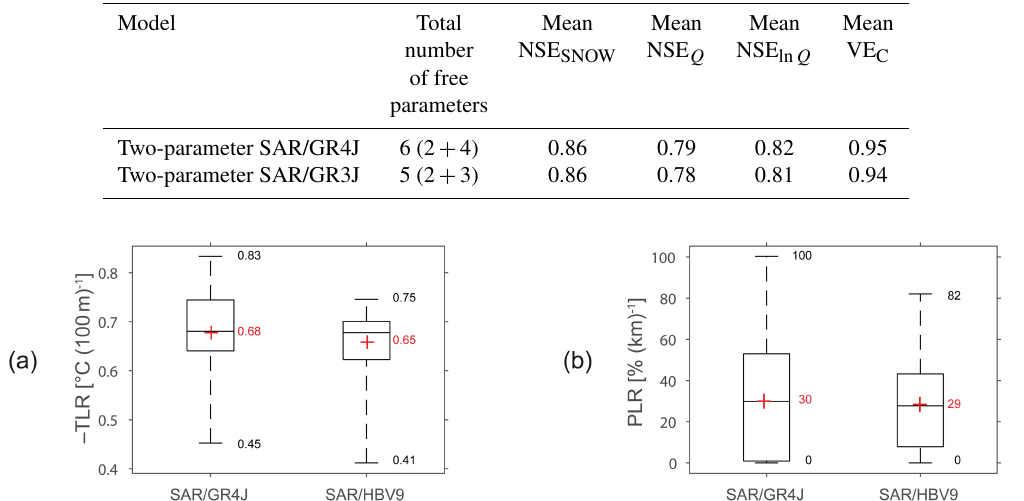
Figure 9. Boxplots (showing 0.00, 0.25, 0.50, 0.75, and 1.00 percentiles) of the ranges of (a) temperature and (b) precipitation lapse rates calibrated with the two-parameter SAR (Test no. 4) in association with the GR4J and HBV9 models on the 20 snow-affected Alpine catchments. The red crosses indicate mean